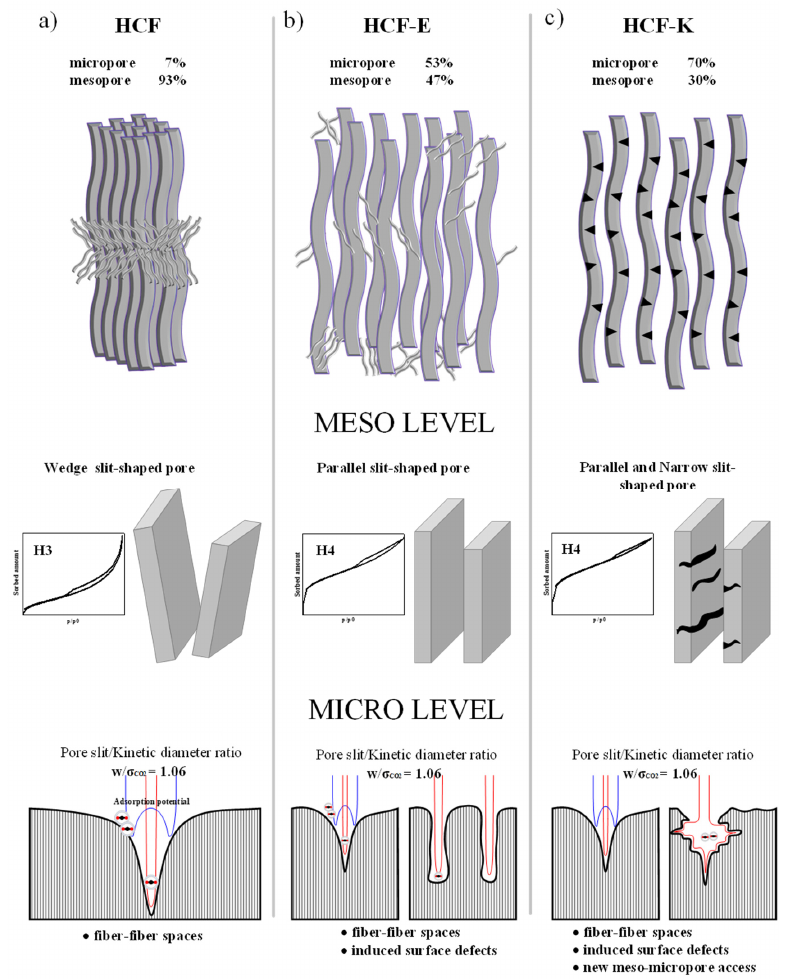
Figure 5. Morphological and CO 2 adsorption synergy of ( a ) HCFs, ( b ) HCF-E and ( c )